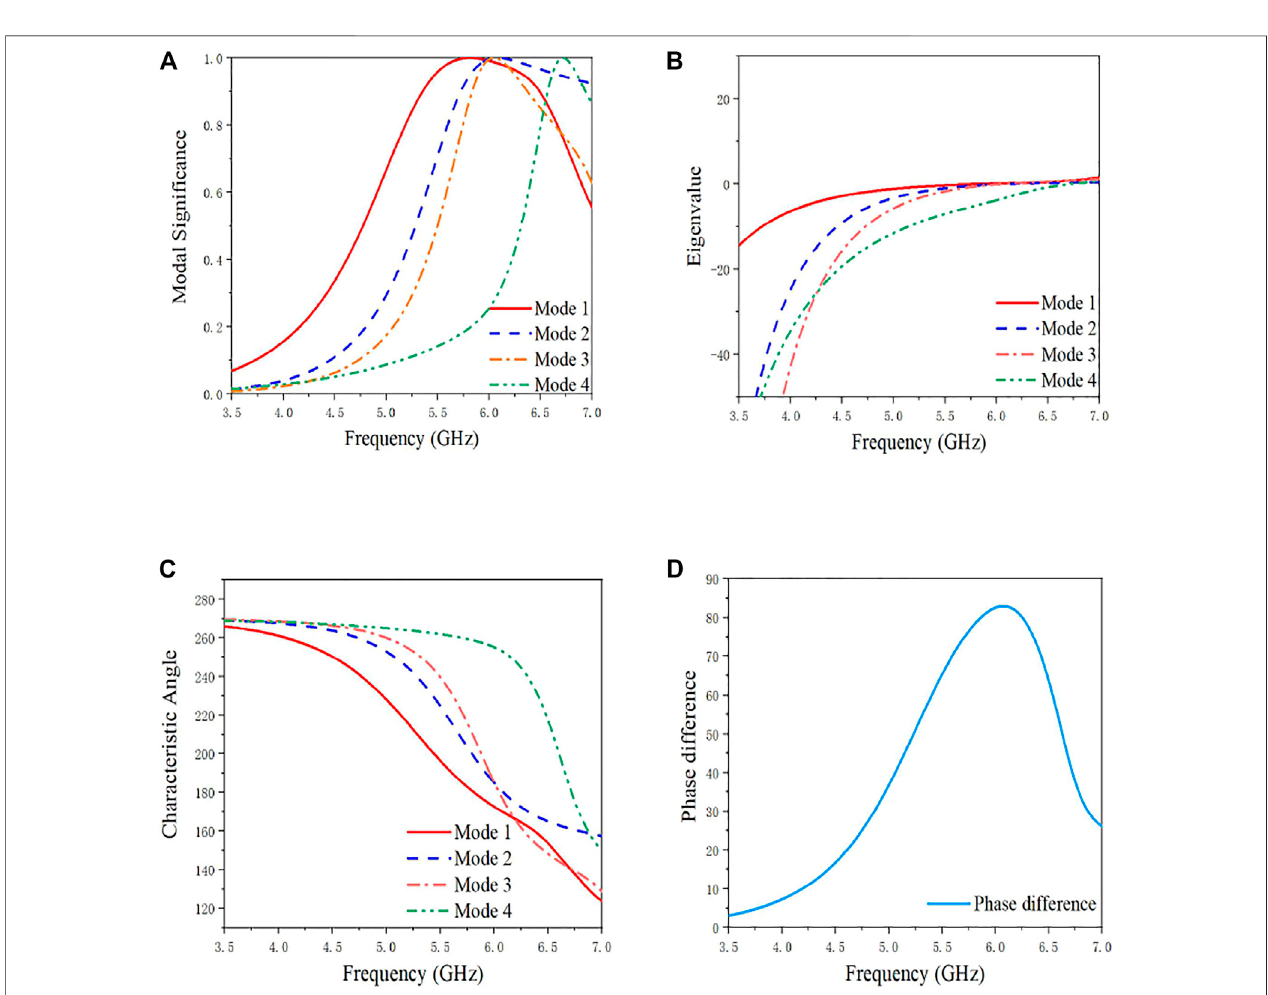
FIGURE 2 | MS, eigenvalue, and CA of the metasurface layer and the difference between the CA of Mode 1 and Mode 4: (A) MS; (B) Eigenvalue; (C) CA; (D) Difference of CA.